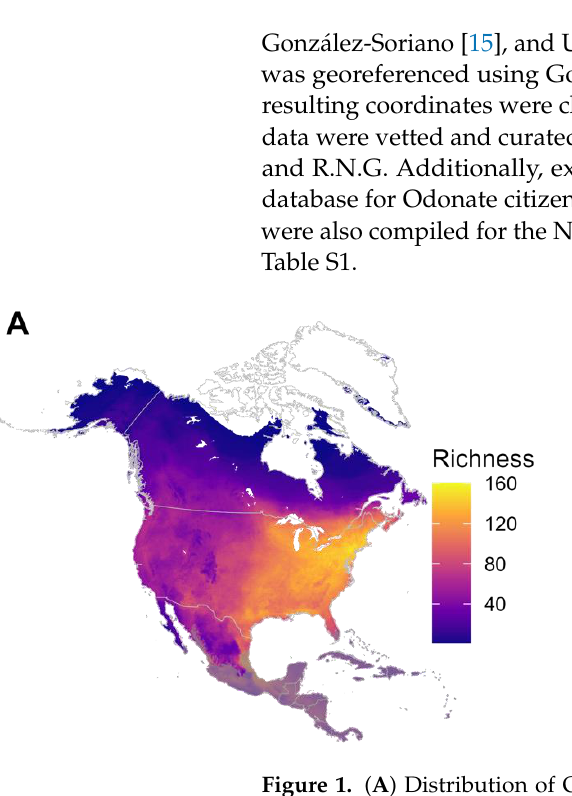
Figure 1. ( A ) Distribution of Odonata richness and ( B ) corrected weighted endemism (CWE) of Nearctic Odonates. Gray shading represents the Neotropical realm.